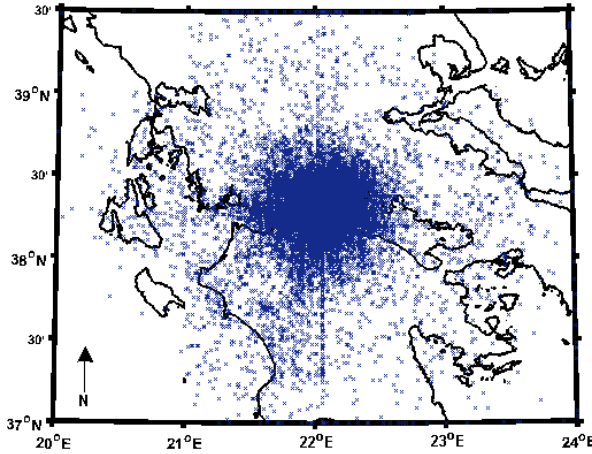
Fig. 1. Map of central Greece with the earthquakes recorded from the CRL network during Figure 1: Map of central Greece with the earthquakes recorded from the CRL network 2 during 2001-2008. 3